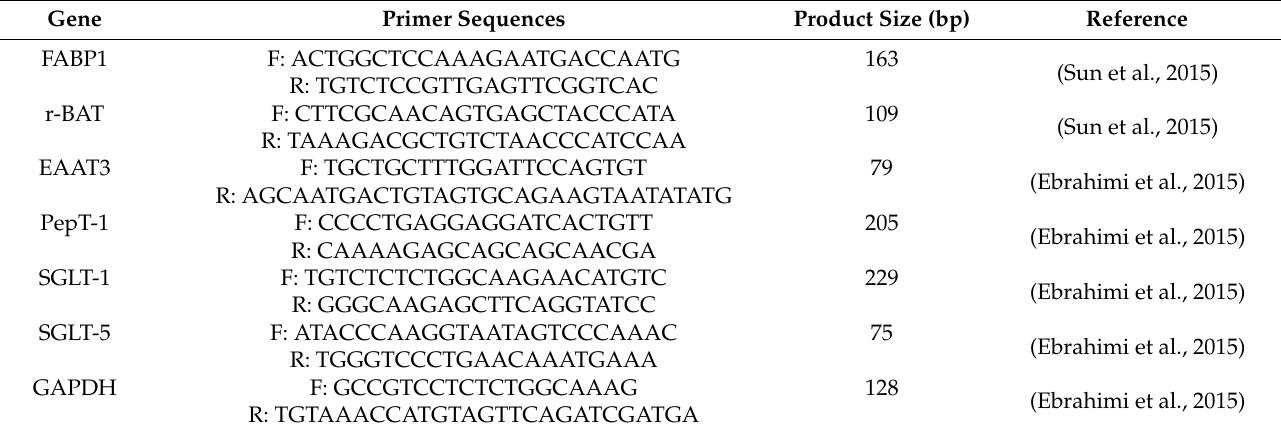
Table 3. Primer sequence for gene expression